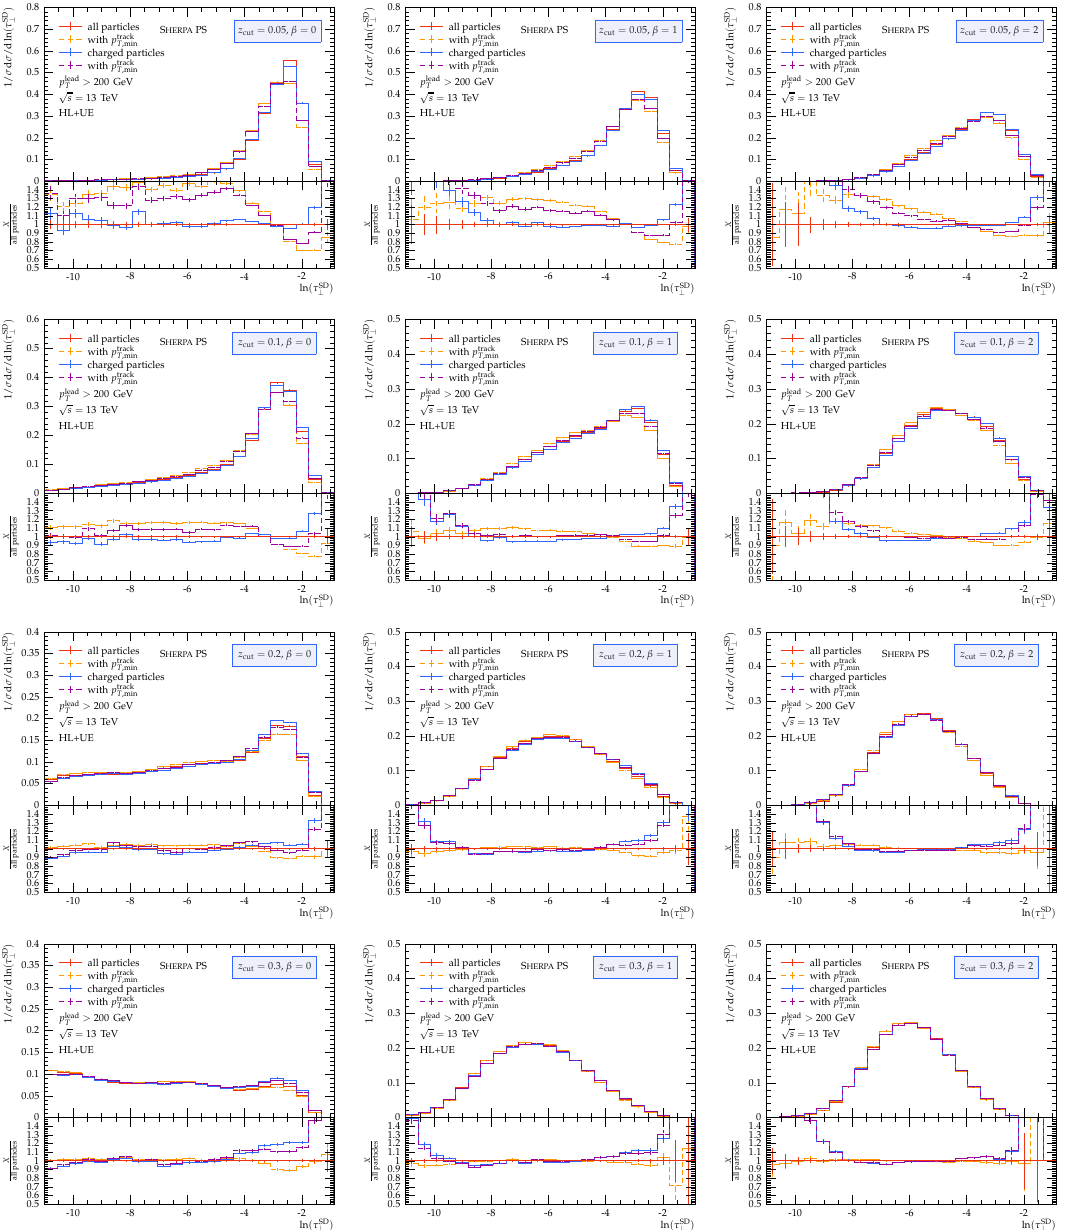
Figure 14 . Hadron-level results for groomed thrust for β ∈ { 0 , 1 , 2 } (columns) and z cut ∈ { 0 . 05 , 0 . 1 , 0 . 2 , 0 . 3 } (rows) for the p T, min = 200 GeV event selection. Shown are predictions from a parton-shower based S HERPA simulation, where the observable gets determined from all or charged final-state particles only. In addition, the effect of a minimal particle transverse-momentum cut of p track = 500 MeV is studied. The lower panels show ratios with respect to the all particles and no T, min track- p T cut